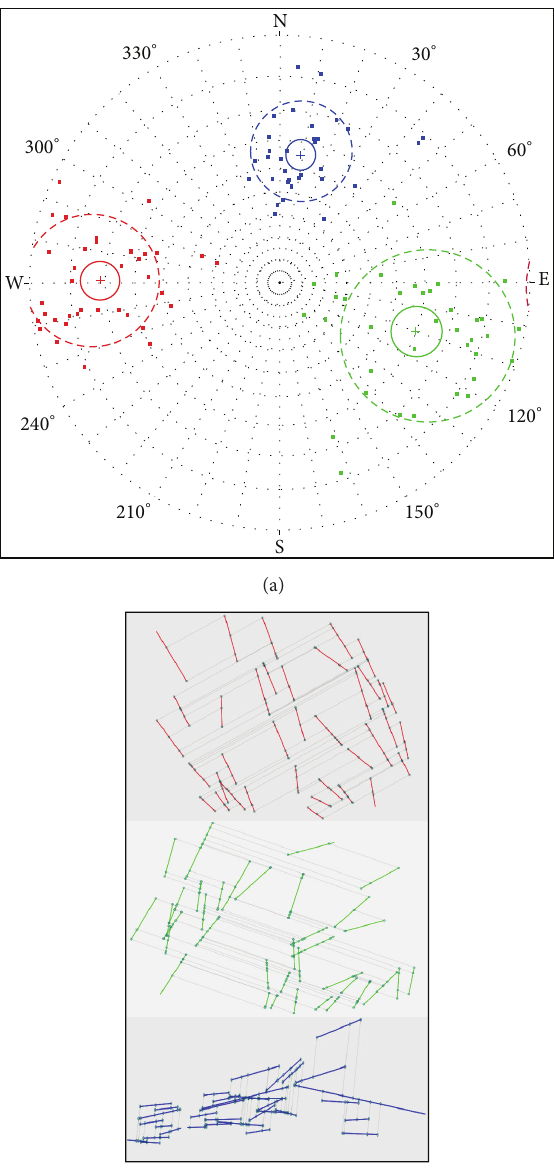
Figure 4: Stereographic plot and the distribution of total three sets of